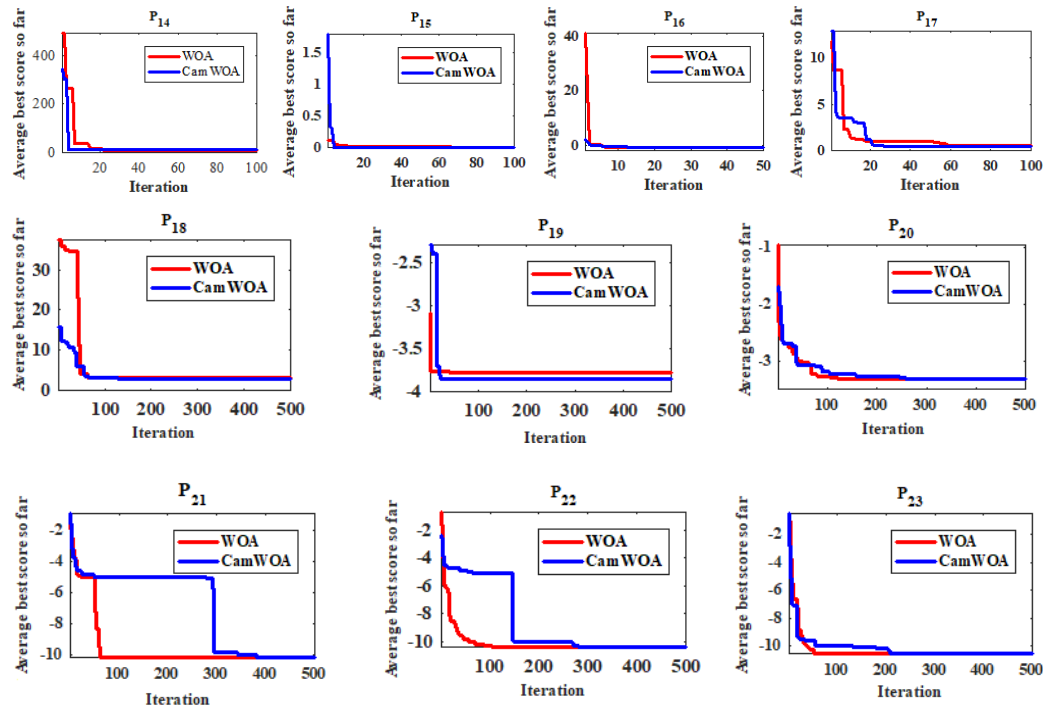
Figure 6. Convergence plot for functions 𝑝 (cid:2869)(cid:2872) , 𝑝 (cid:2869)(cid:2873) , 𝑝 (cid:2869)(cid:2874) , 𝑝 (cid:2869)(cid:2875) , 𝑝 (cid:2869)(cid:2876) , 𝑝 (cid:2869)(cid:2877) , 𝑝 (cid:2870)(cid:2868) , 𝑝 (cid:2870)(cid:2869) , 𝑝 (cid:2870)(cid:2870) , 𝑝 (cid:2870)(cid:2871)